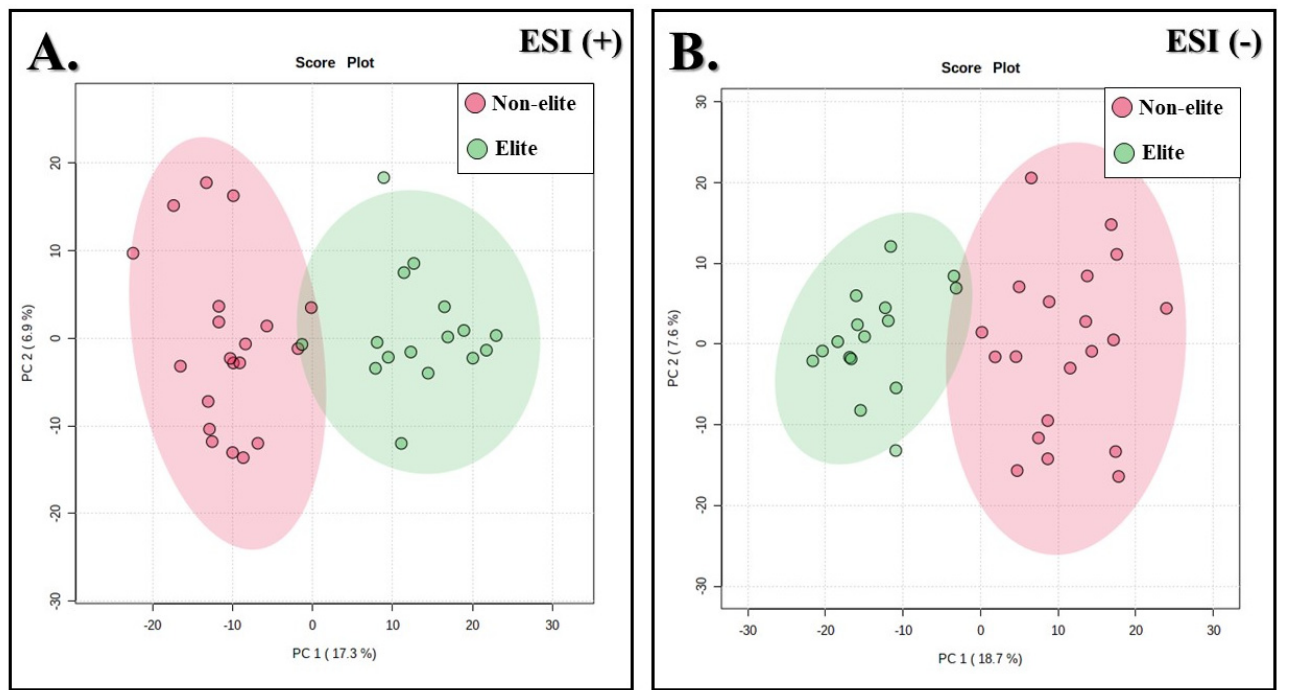
Figure 3. PCA score plots of all serum samples from both soccer teams for the ESI (+) ( A ) and ESI ( − ) modes ( B ). Colors represent different soccer teams (red: non-elite athletes; green: elite athletes).